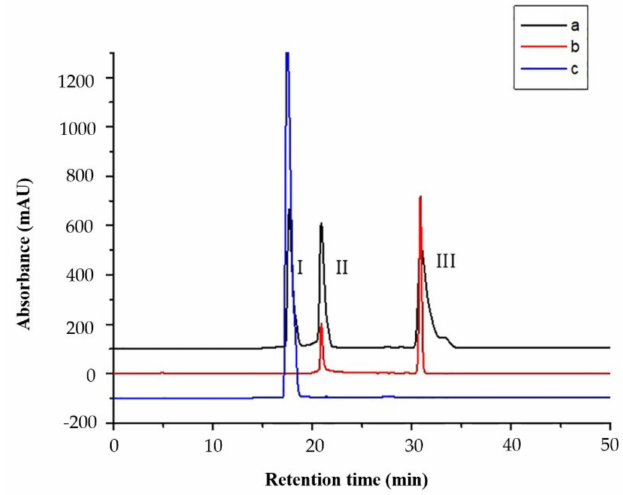
Figure 4. HPLC chromatograms (254 nm) of ( a ) the ligand fishing experiment with a prepared test mixture consisting of dexamethasone (I), tanshinone IIA (II) and curcumin (III). Non-binders II and III were washed out ( b ), whereas binder I was eluted with methanol ( c ).